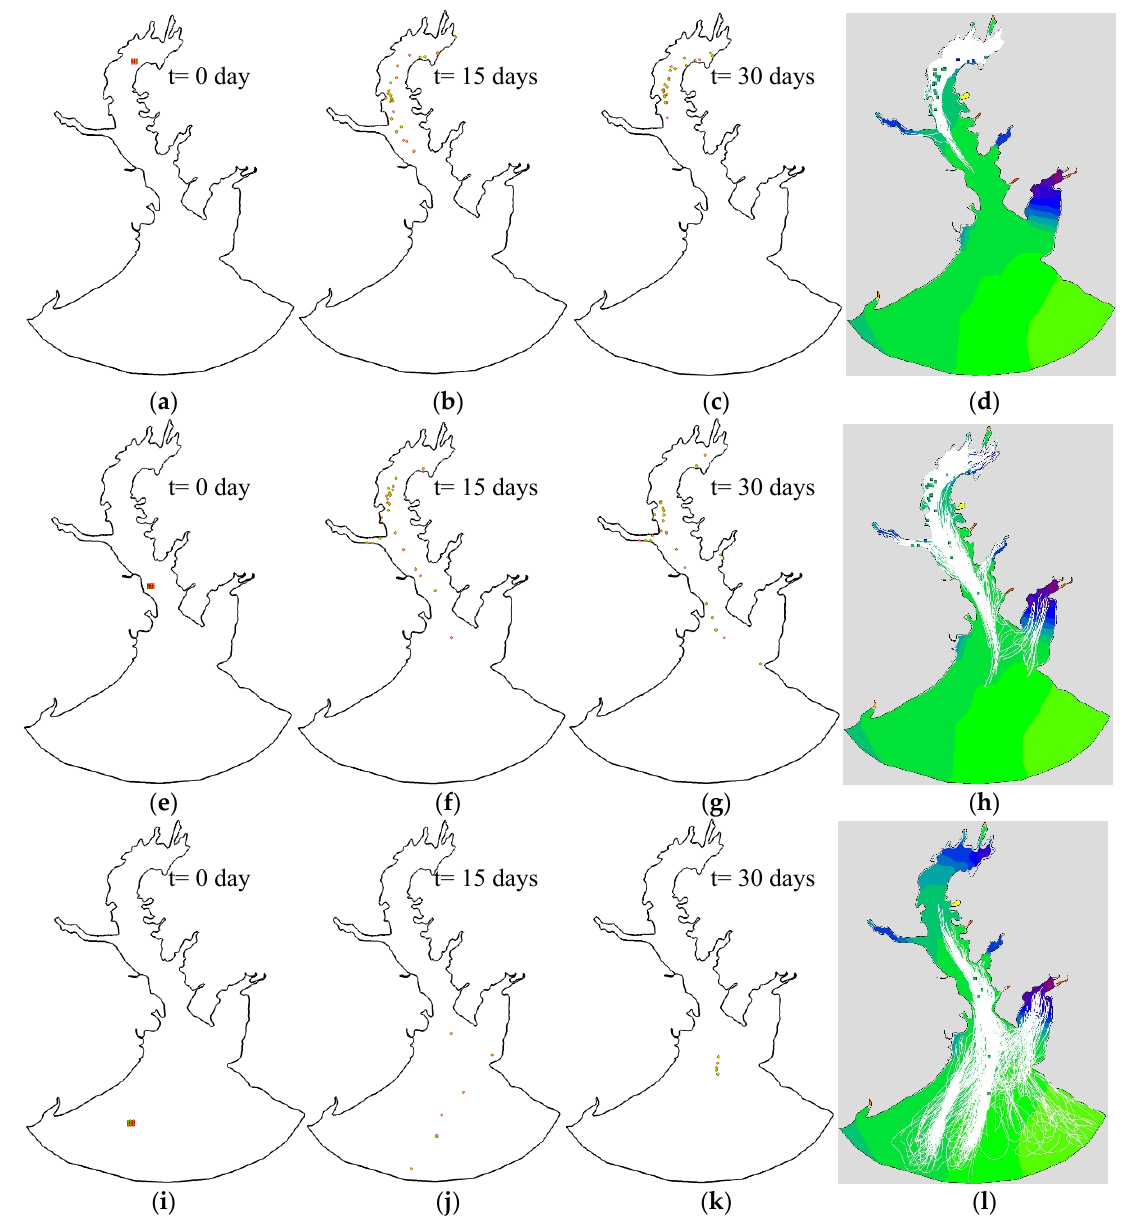
Figure 11. Spatial distribution of particle trajectories (colored dots) at selected sub-zones during 1 June–1 July 2008. ( a – d ) represent the particles released at the bay head; ( e – h ) represent the releases at Shitoubu, the middle of the bay; and ( i – l ) represent the releases at west trough located at the entrance of the bay.